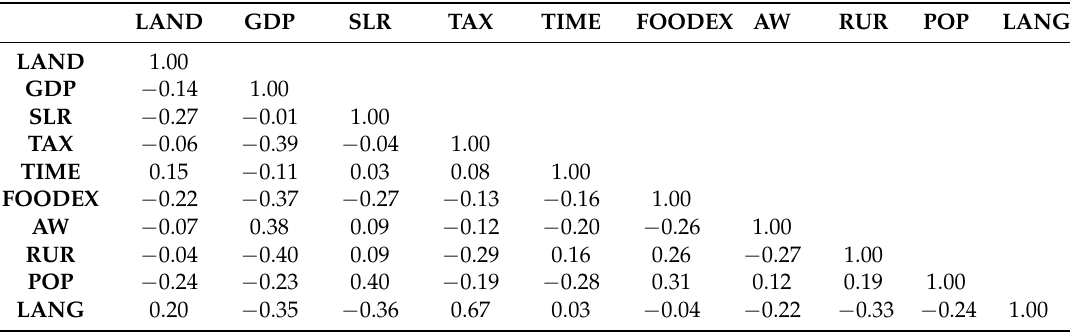
Table 4. Correlation among variables of the “access for investors”